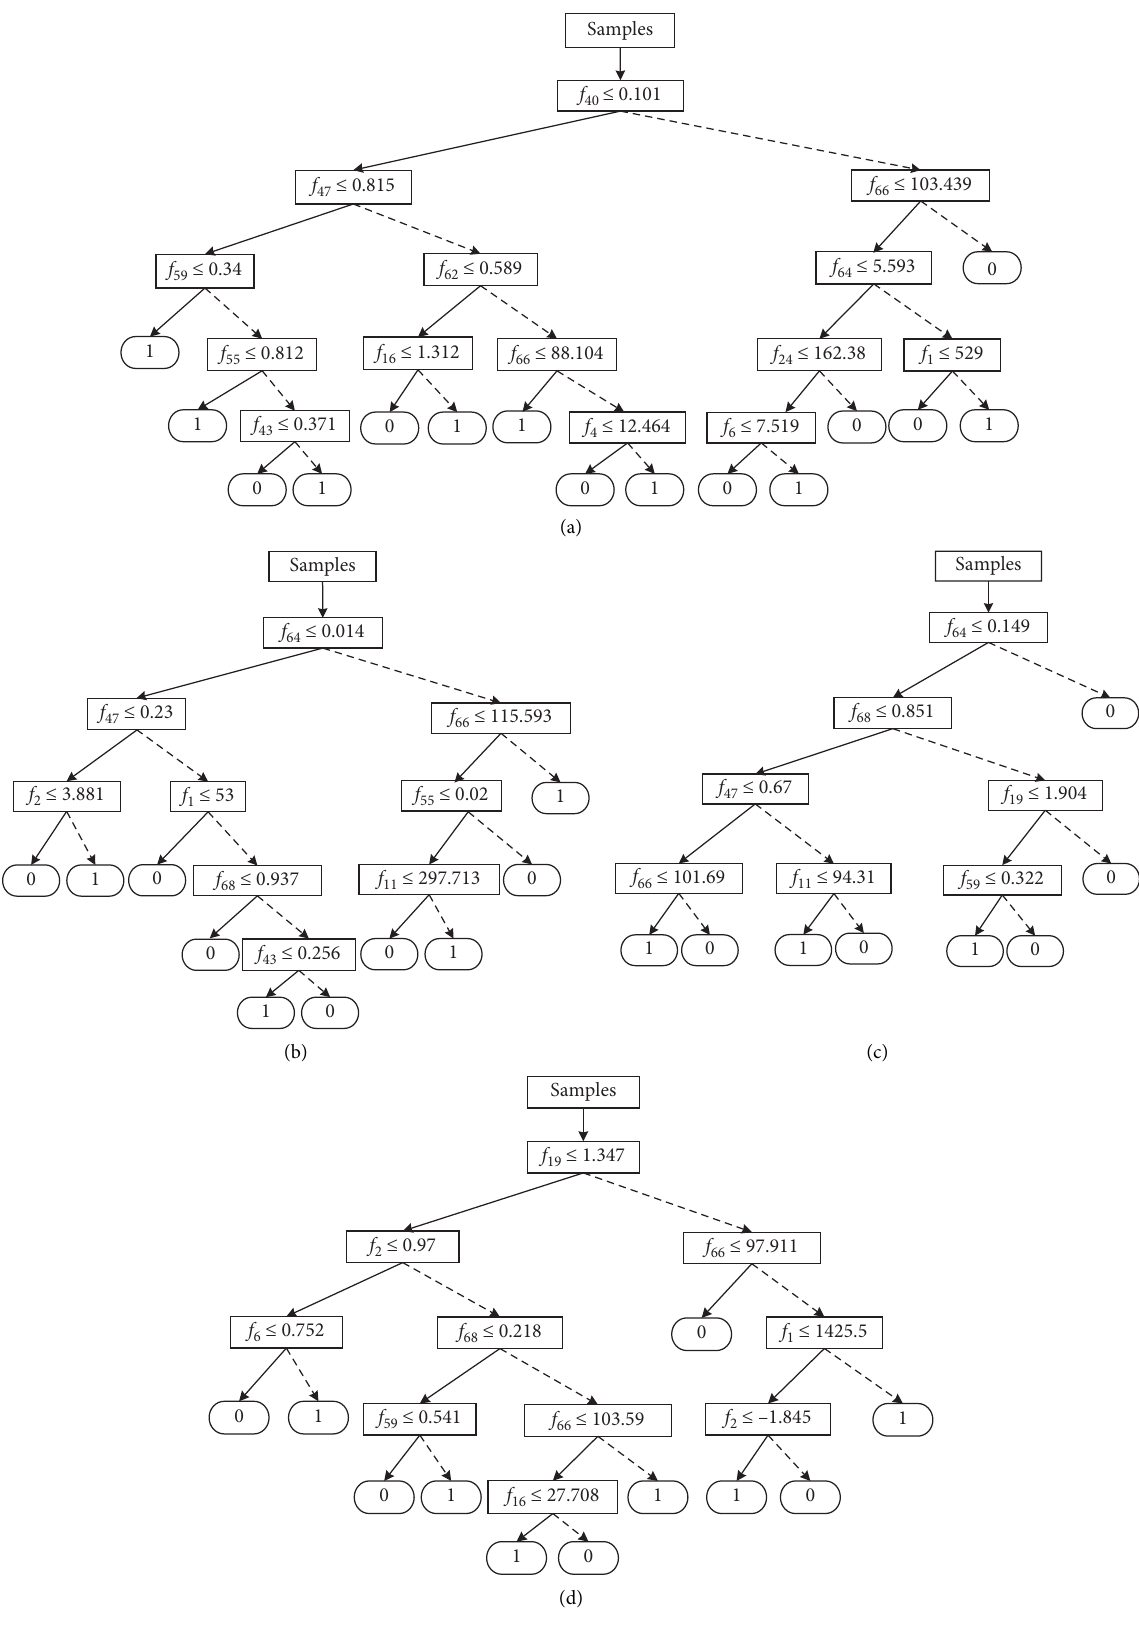
Figure 3: Decision tree at feature level. (a) Vehicle, (b) pedestrian, (c) bicycle, (d)